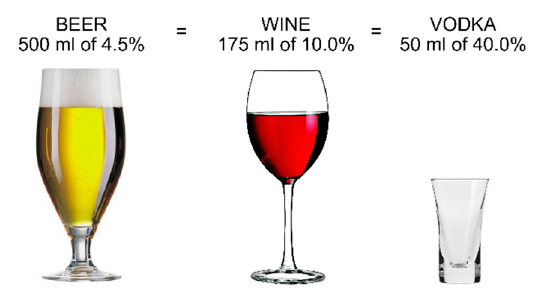
Figure 2. The Polish standard drink (own elaboration).